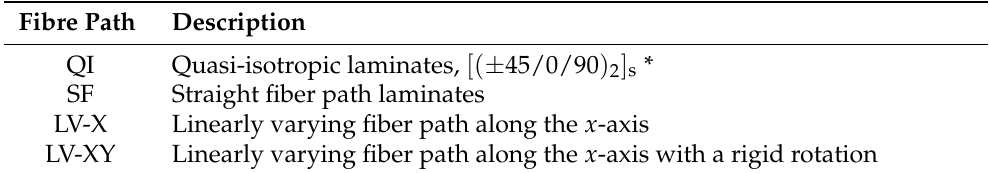
Table 2. Summary of design optimization cases.